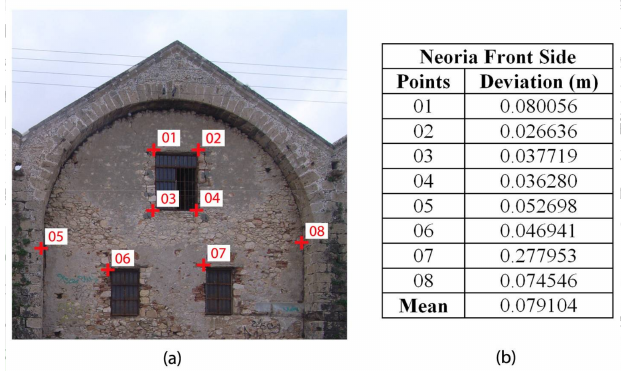
Figure 11. Accuracy assessment via GCP of Neoria front side façade: ( a ) GCP distribution along the façade; and ( b ) deviations of the GCP along with their mean value.